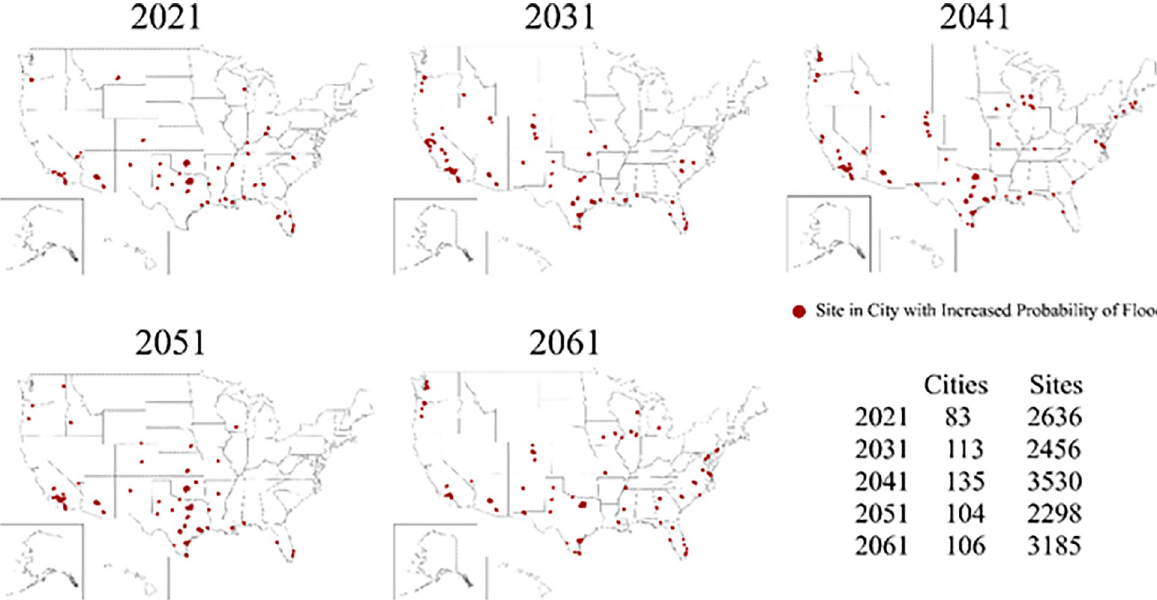
Fig 1. Cities with predicted flood probabilities above their historical baseline for the years 2021, 2031, 2041, 2051, and 2061. The number of sites at risk in each city varies resulting in the possibility of fewer cities, but more sites at risk of flooding—and vice versa—in a given year.